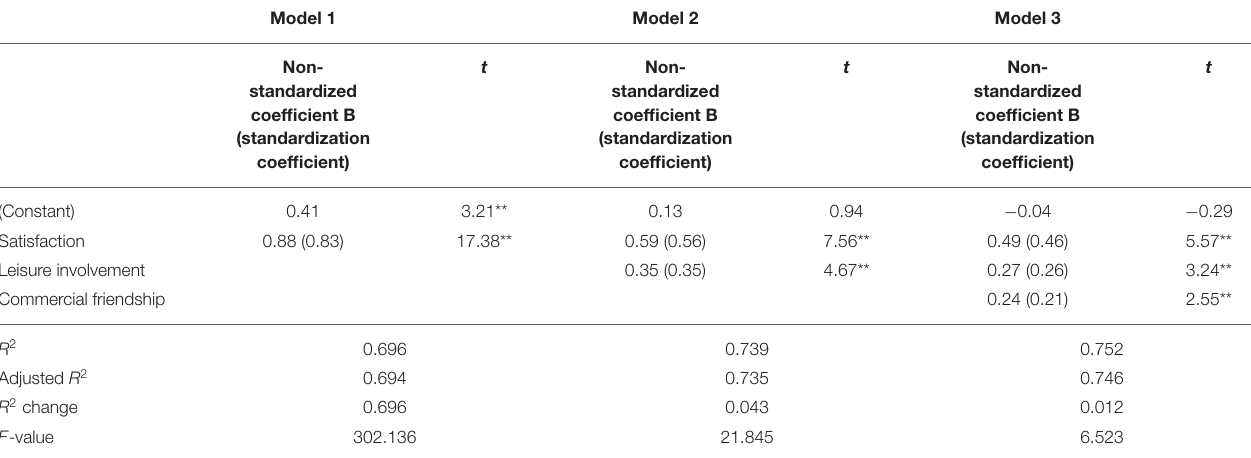
TABLE 3 | Summary of the results of the multivariate hierarchical regression of each variable explaining repurchase